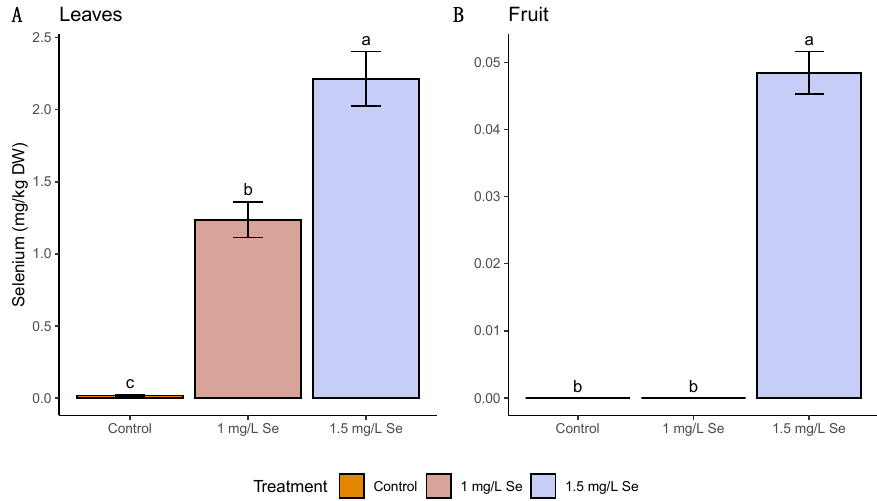
Figure 1. Total Se content in the leaves ( A ) and fruit ( B ) of tomato plants (cv. Kreos) treated 1 month after transplanting with 0, 1, and 1.5 mg Se L − 1 as Se NPs. Leaves and fruit were sampled 18 and 46 DAT (days after treatment), respectively. Bars indicate standard error. Letters indicate the results of the LSD test run separately for each organ. Values with the same letter are not statistically different ( p ≤ 0.05; n = 4).